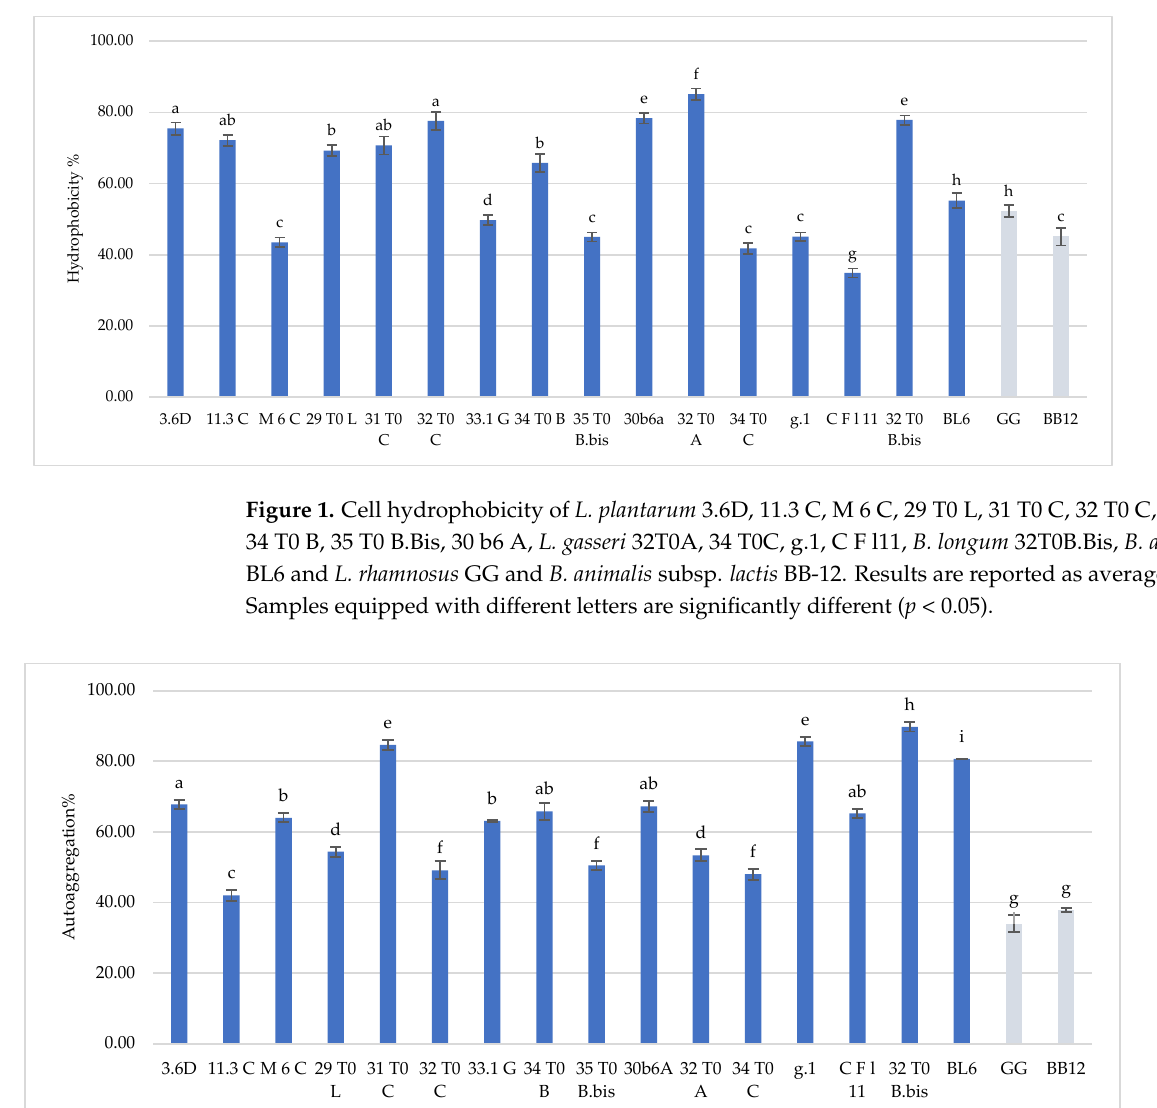
Figure 2. Cell autoaggregation of L. plantarum 3.6D, 11.3 C, M 6 C, 29 T0 L, 31 T0 C, 32 T0 C, 33.1 G, 34 T0 B, 35 T0 B.Bis, 30 b6 A, L. gasseri 32T0A, 34 T0C, g.1, C F l11, B. longum 32T0B.Bis, B. animalis BL6 and L. rhamnosus GG and B. animalis subsp. lactis BB-12. Results are reported as average ± SD. Samples equipped with different letters are significantly different ( p < 0.05).